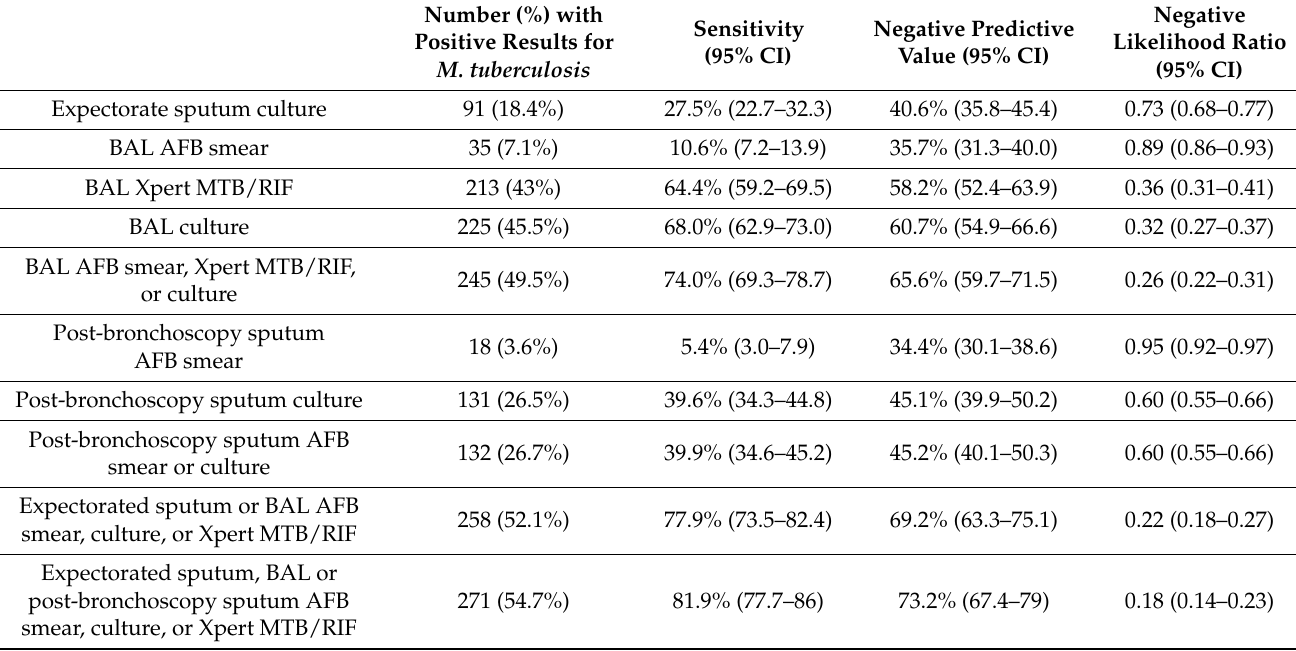
Table 2. Diagnostic yield for the confirmation of active tuberculosis based on individual and combi- nations of tests and